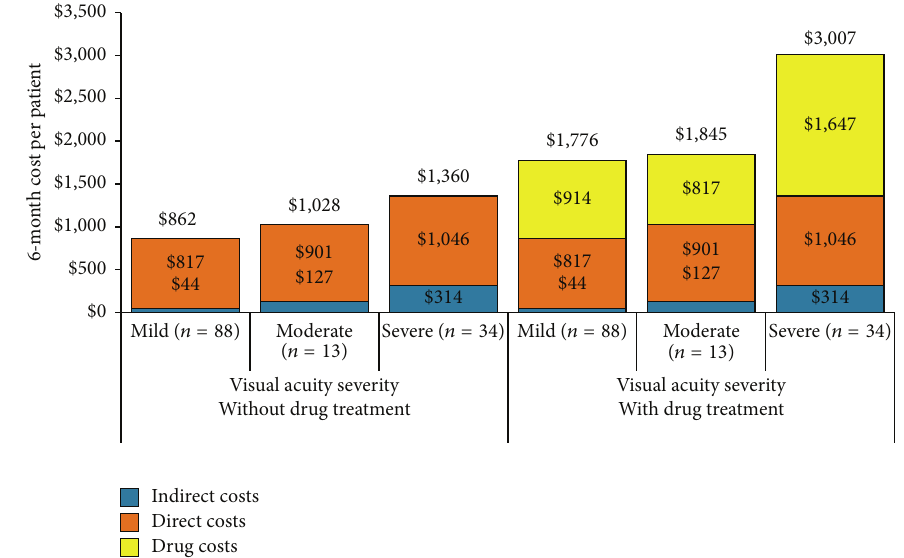
Figure 1: Mean 6-month DME-related costs per patient by visual acuity severity: with and without drug costs.